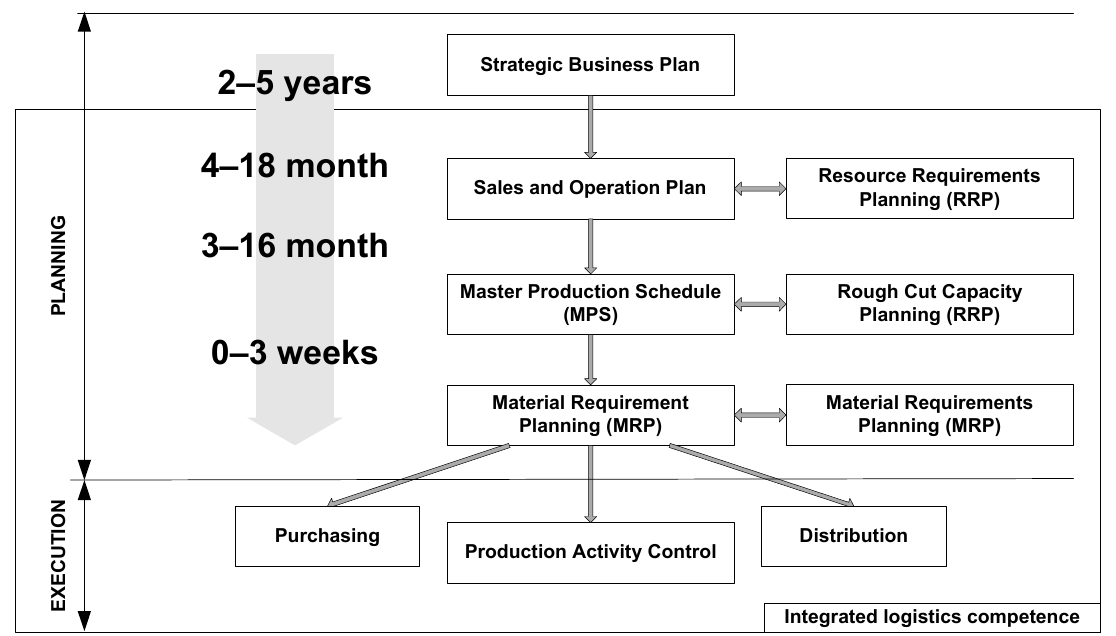
Figure 2. The planning system of the case study company.